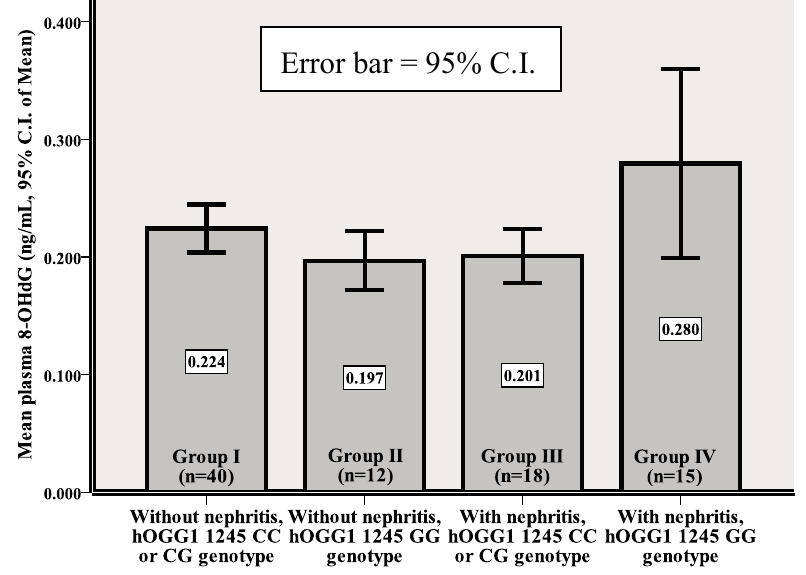
Figure 3. The plasma 8-OHdG in SLE patients with or without nephritis, as related to different hOGG1 C1245G genotypes (mean levels and 95%